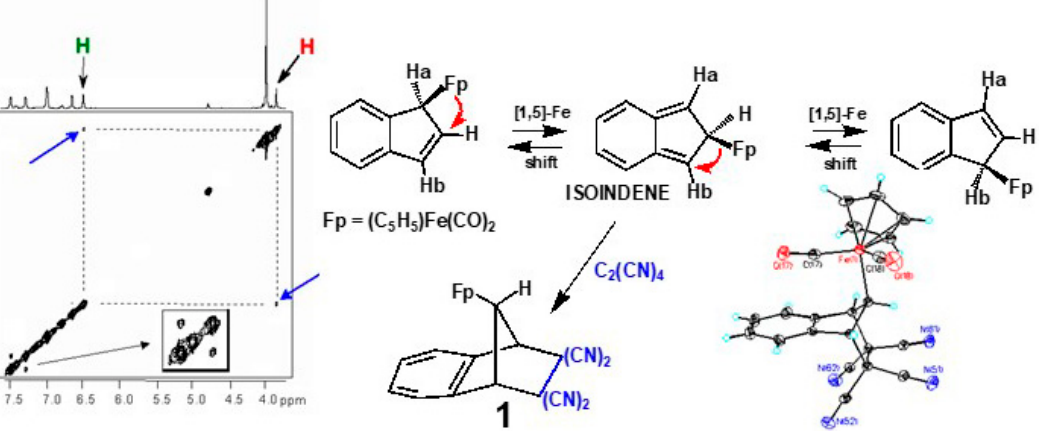
Figure 1. (Left) 500 MHz 2D EXSY NMR spectrum showing exchange between Ha and Hb in ( η 5 -C 5 H 5 )(CO) 2 Fe( η 1 -C 9 H 7 ) at 45 °C, and (right) molecular structure of 1 , the Diels-Alder adduct of tetracyanoethylene (TCNE) to the isoindene intermediate.